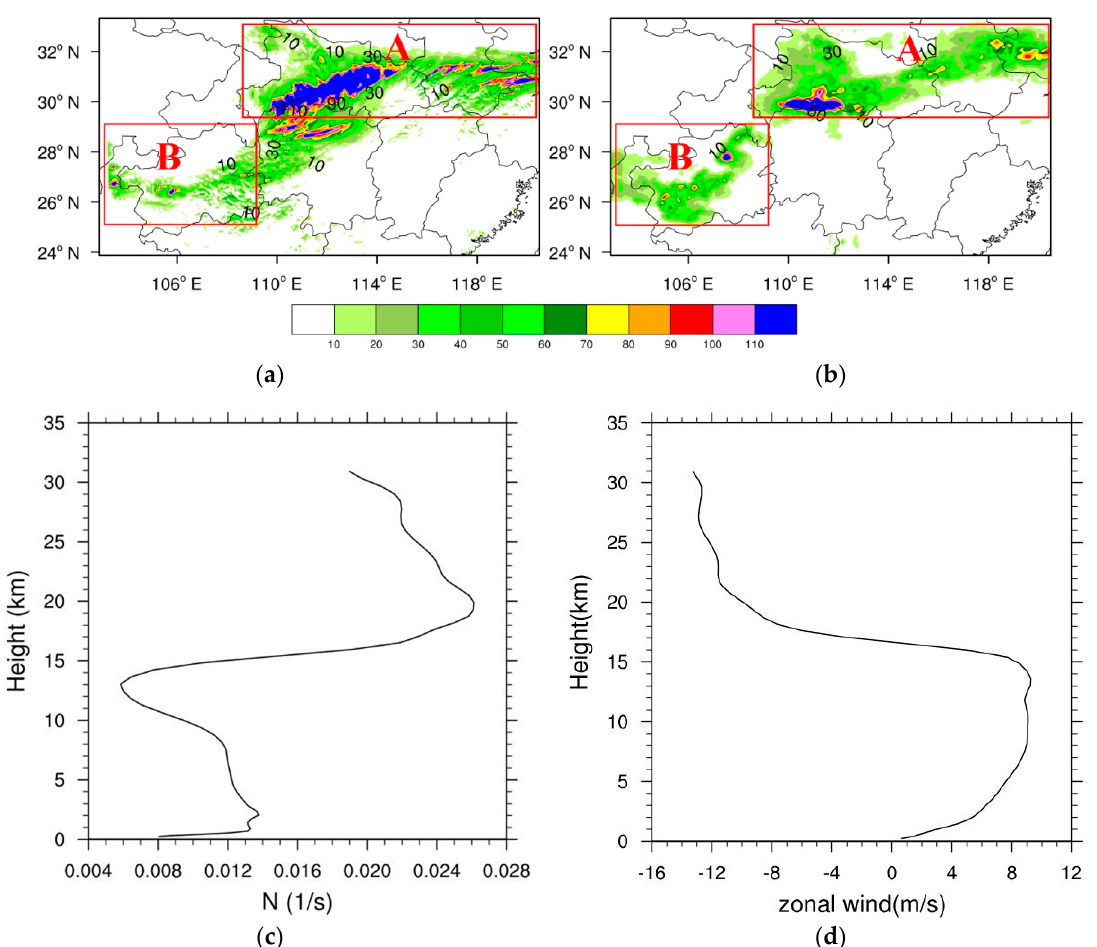
Figure 3. The 12 h accumulated precipitation (shading; mm) from 1200 UTC 17 June to 0000 UTC 18 June of the simulation ( a ), and the observation ( b ). The red boxes A and B are shown in Figure 3a,b, indicating two areas of the rainfall. The vertical profiles of the averaged Brunt–Väisälä frequency (s − 1 ) ( c , d ) the averaged zonal wind (m s − 1 ) at 0000 UTC 18 June. The distributions of vertical velocity and horizontal wind are shown in Figure 4a,b. In Figure